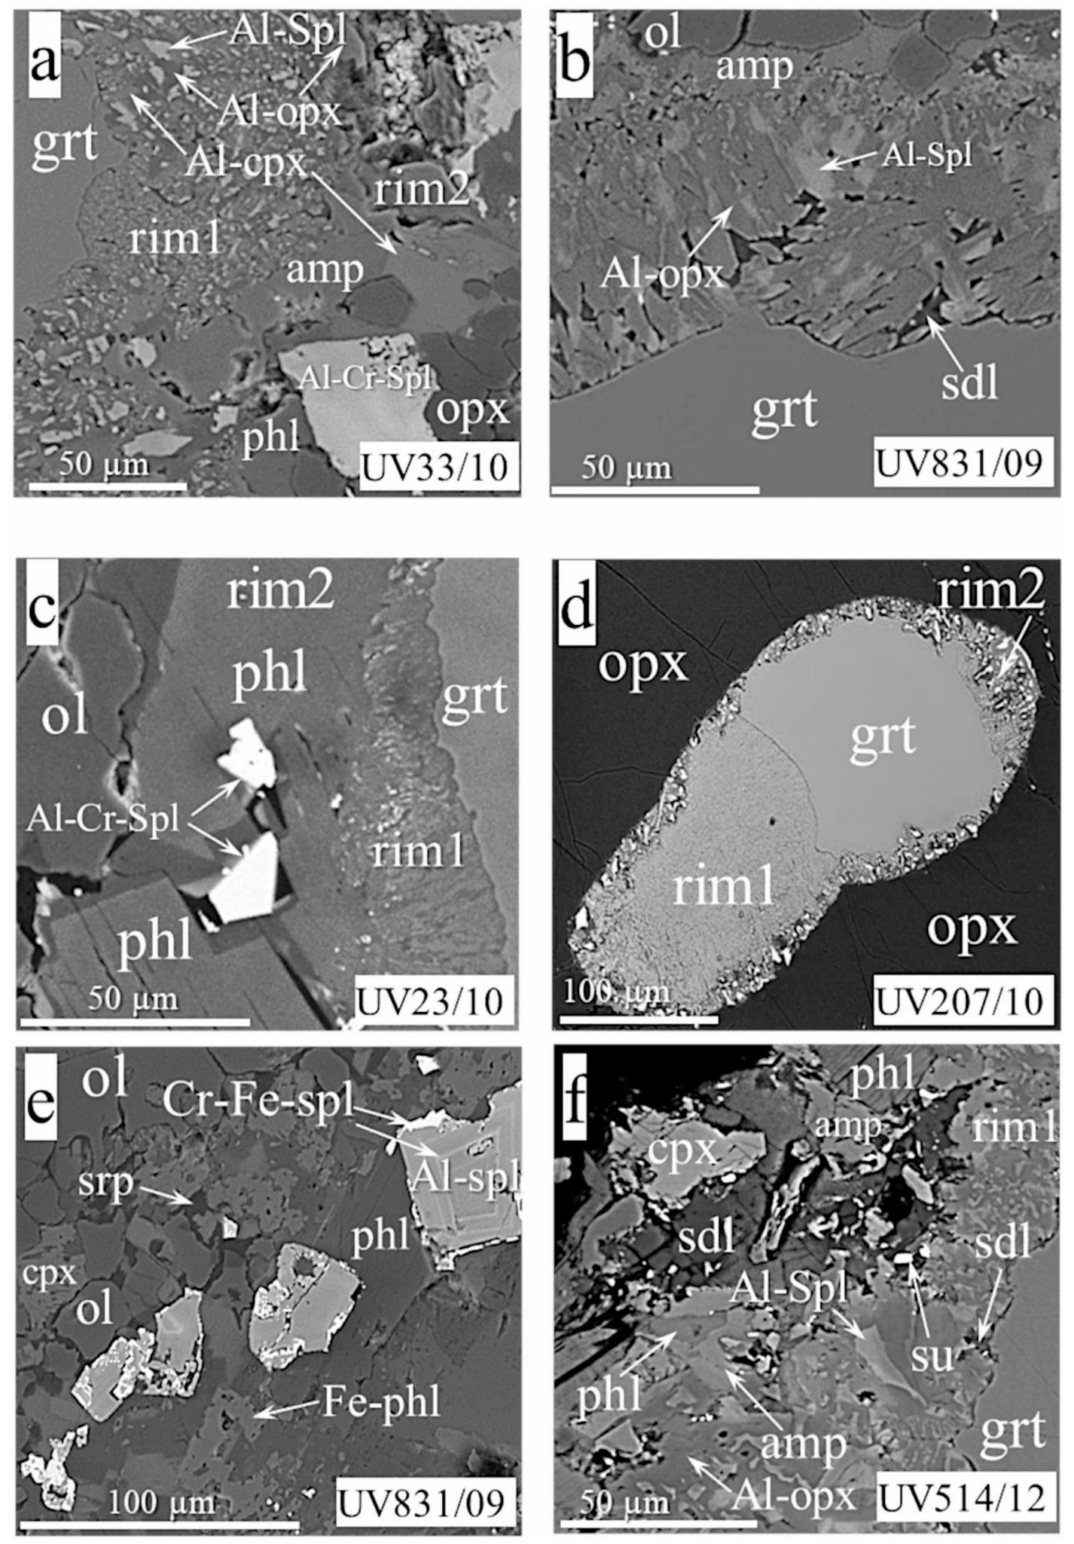
Figure 3. BSE images of the kelyphitic rims on pyropes from ShP: ( a ) Rim1, bordered by rim2, which is represented by large grains of pyroxenes, spinel, phlogopite, and amphibole; ( b ) unusually “coarse-grain” rim1; ( c ) rim1 bordered by phlogopite with rare Al-Cr spinel grains (rim2); ( d ) garnet grains in orthopyroxene with pronounced rims 1 and 2; ( e ) rim2, folded by zonal phlogopite and spinel, is the outer part of the rim1 shown in ( b ); ( f ) rims 1 and 2 without a clear boundary between